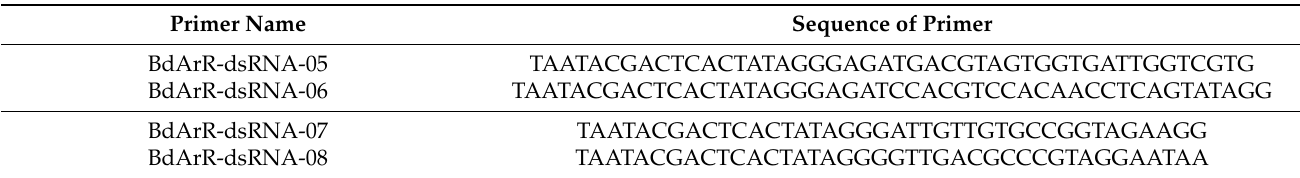
Table 3. Sequences of specific primers used for the synthesis of ds Bdfbp1 RNA.